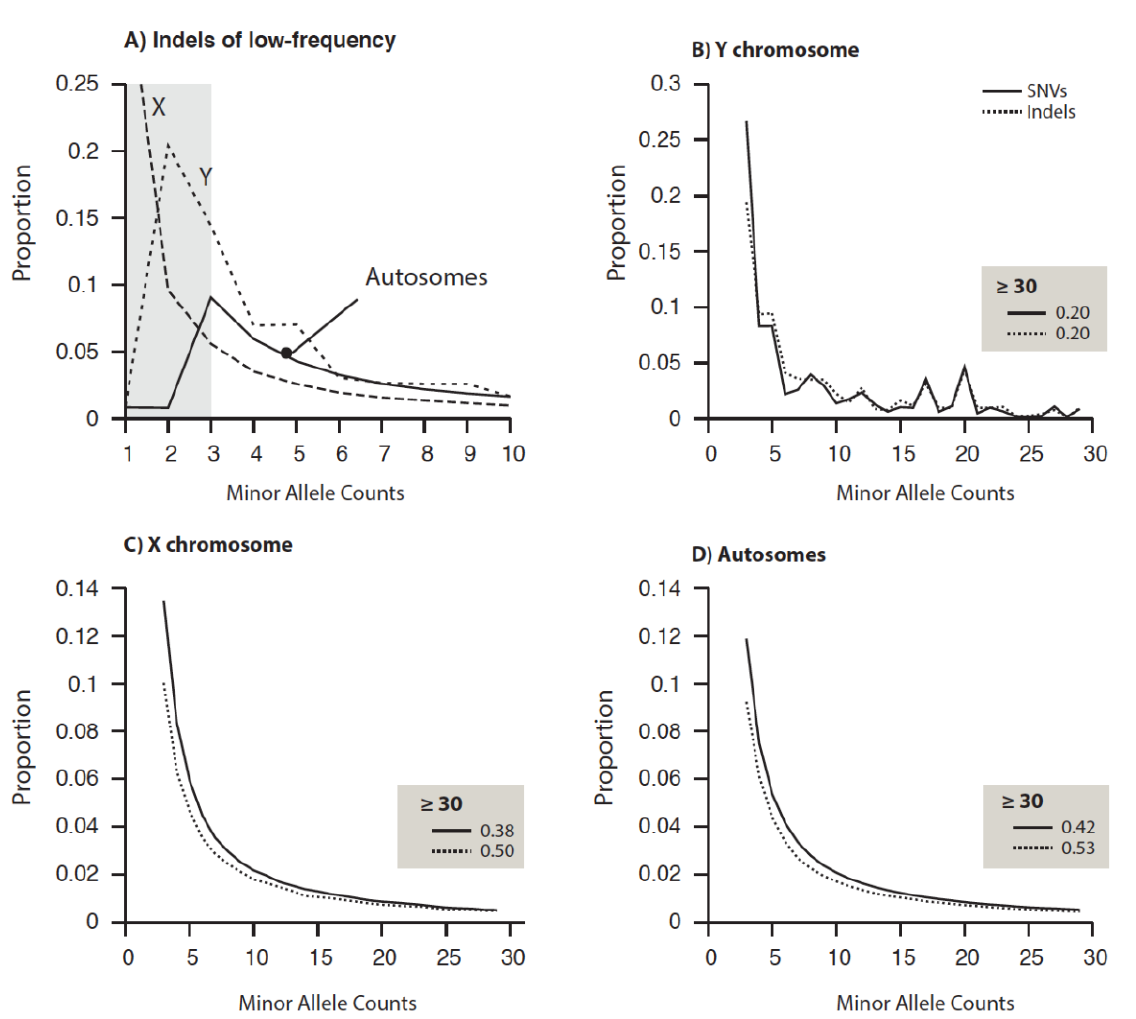
Supplementary Figure 1 – Allele Frequency Spectra (AFS) for SNVs and indels. We report here the distribution of allele frequency (here given by the Minor Allele Count) for bi-allelic variants. A) Normalized AFS for all indels of human chromosomes zoomed on the lowest frequency. B-D) Normalized AFS for SNVs and indels, excluding variants where the minor allele has fewer than 3 counts. Results are given for the Y chromosome (B), the X chromosome (C) and pooled autosomes